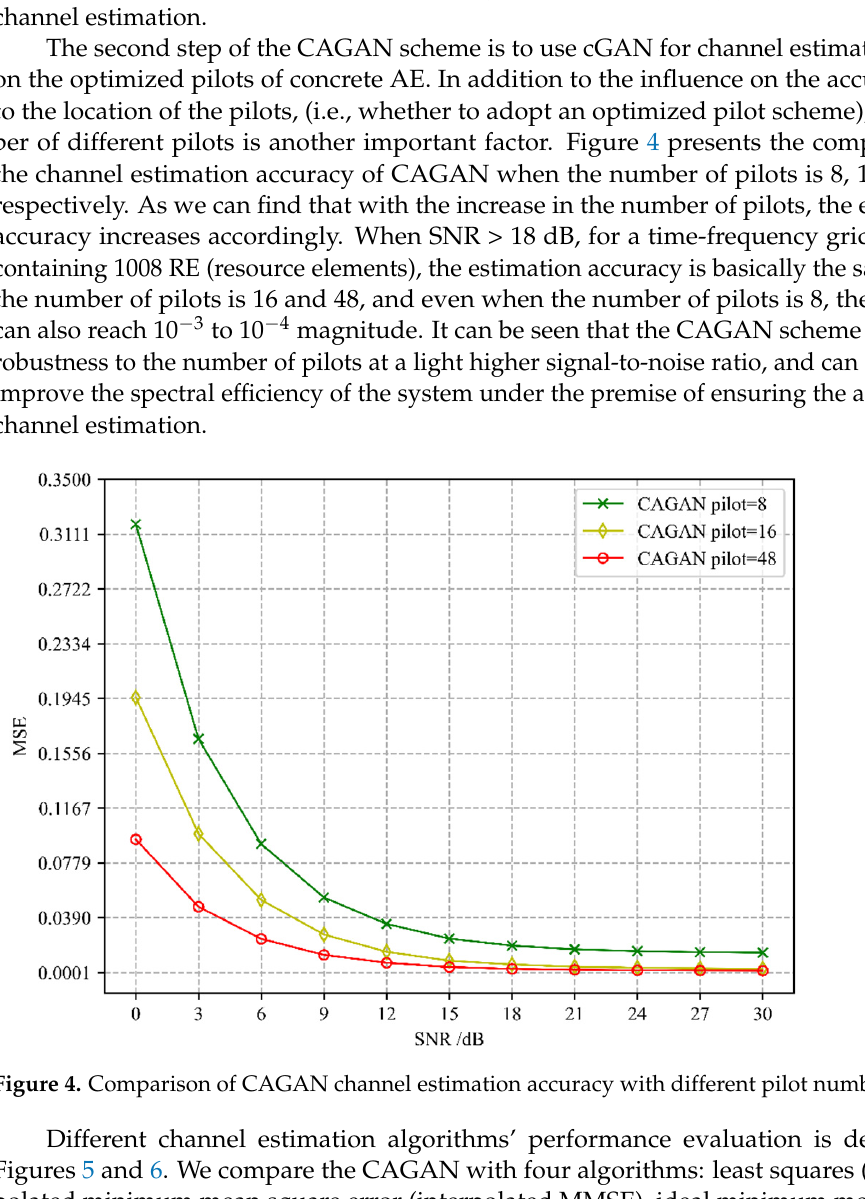
8 of 12 Figure 3. Comparison of channel estimation performance of different algorithms under different pilot numbers when SNR = 15 dB.